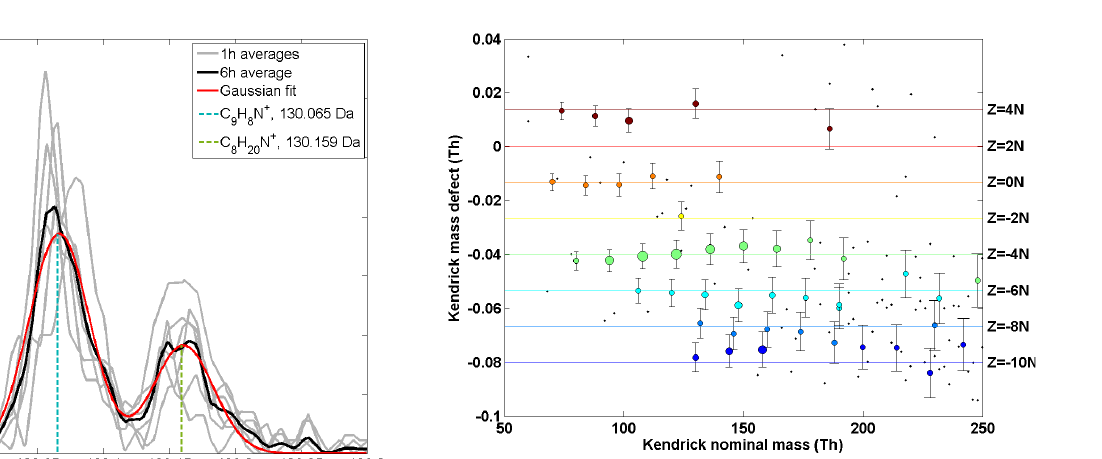
Fig. 13. Kendrick diagram of even m/Q of positive ions converted to Kendrick mass scale. The same coloured circles represent peaks belonging to the same homologous series within 30ppm accuracy. The accuracy is mass dependent according to Fig. 4. Here only nitrogen containing compounds have been presented. Size of the coloured circles is scaled to the logarithm of signal strength.